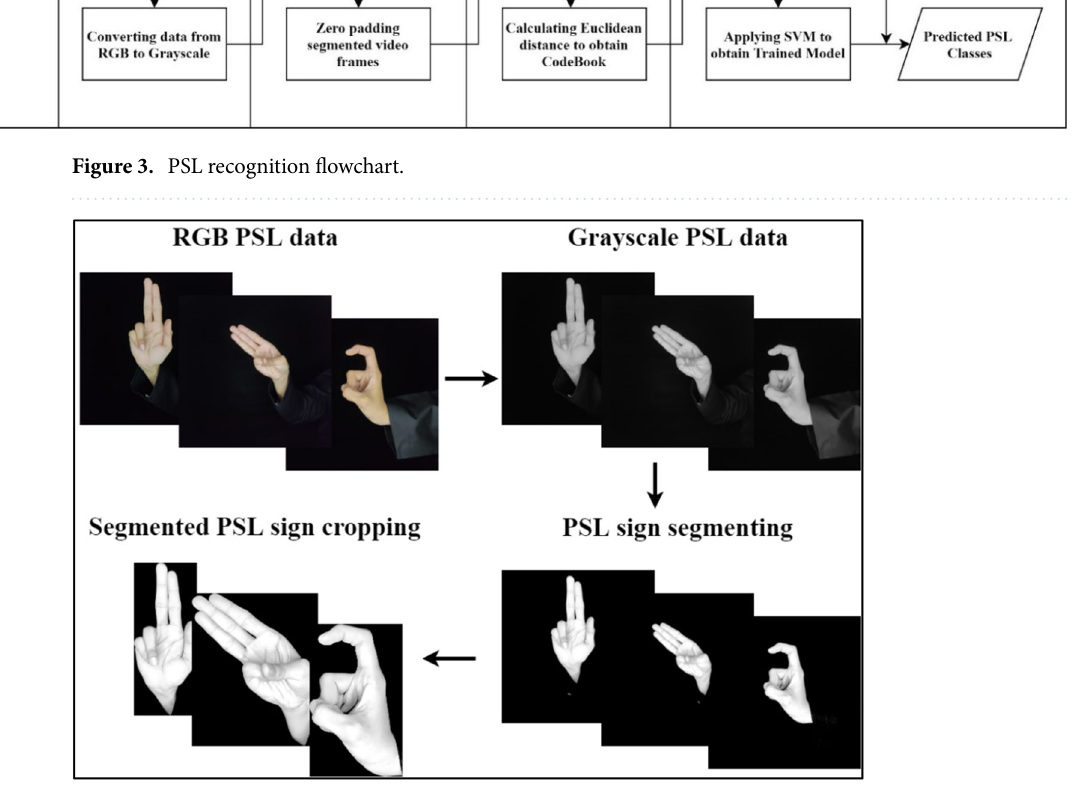
Figure 4. PSL data